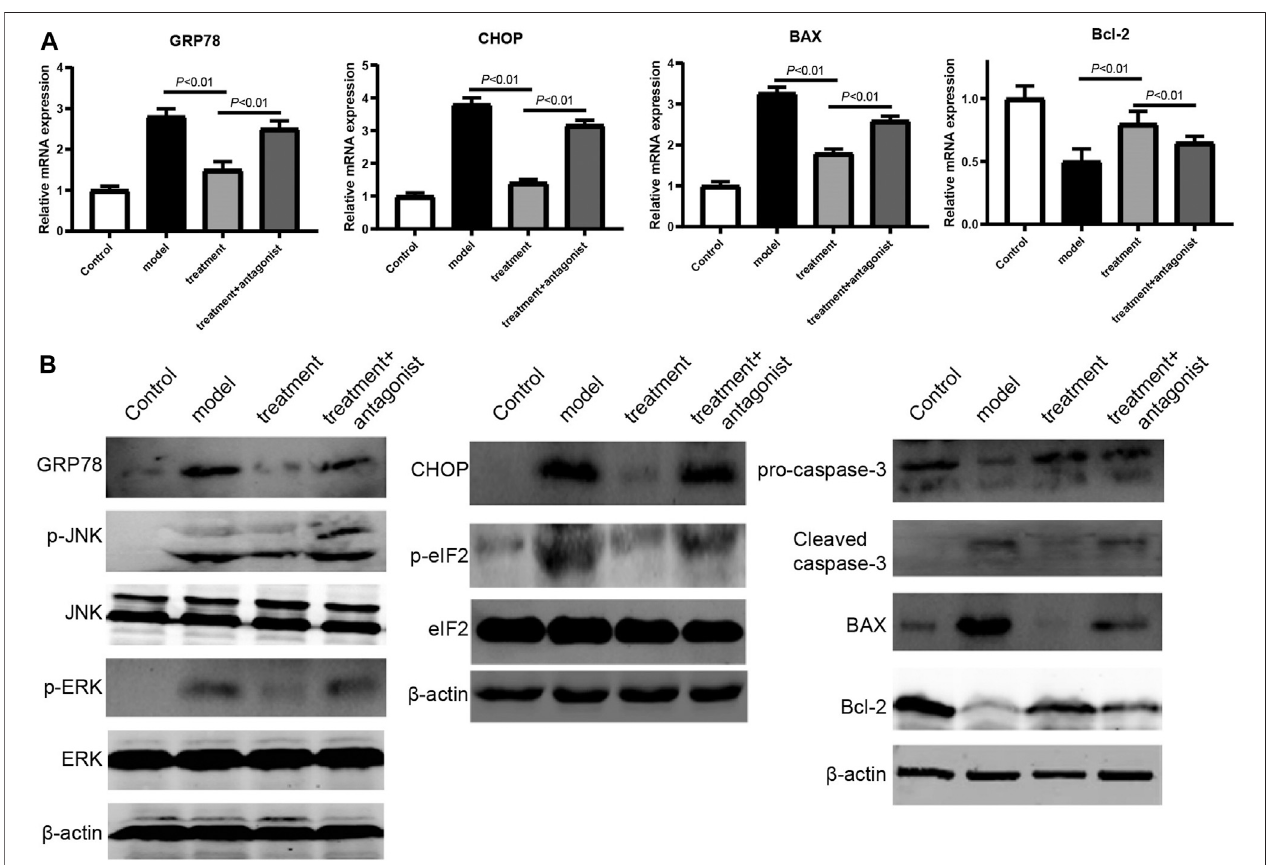
FIGURE2| Ghrelin regulatedUPRpathway and apoptosis inCaco-2cells. (A) RT-qPCRanalysisoftheexpression levelsofGRP78,CHOP, BAX, and Bcl-2. Data were shown as means ± SD (n (cid:2) 3). (B) Westernblot analysisof GRP78, phospho-JNK, and phosphor-ERK. (C) Western blot analysis ofCHOPand phospho-eIF2. (D) Western blot analysis of caspase-3, BAX, and Bcl-2. Representative blots from three independent experiments were shown.